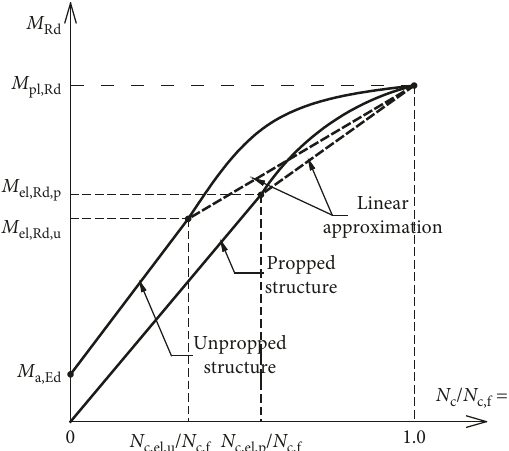
Linear approximation